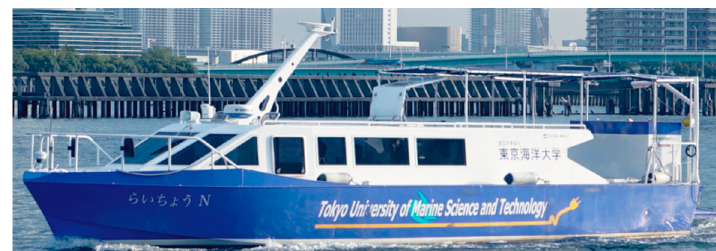
Figure 26. The experimental ship “Raicho N” [127].